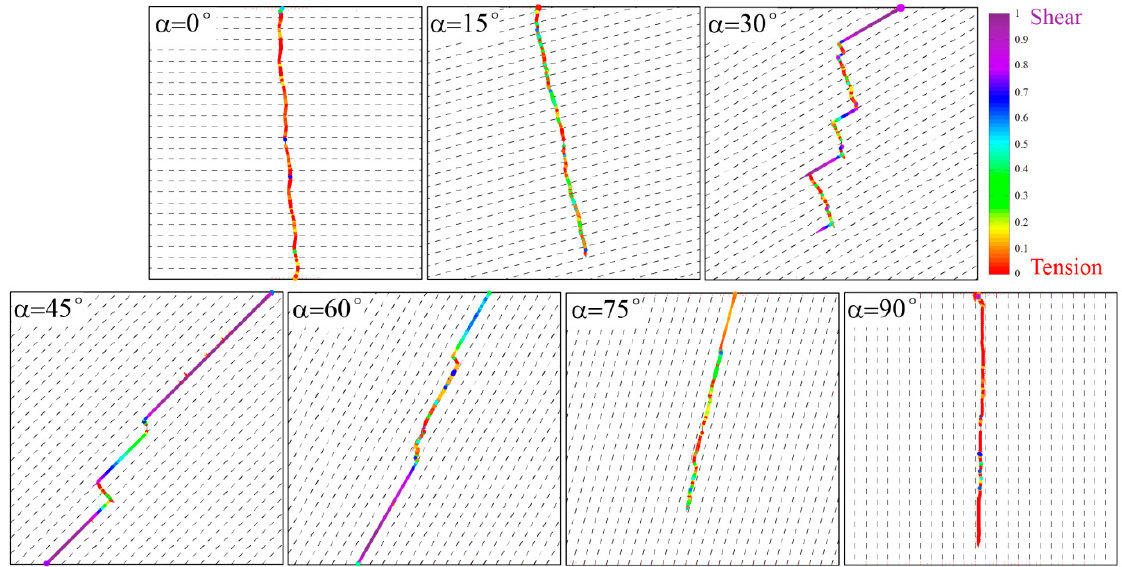
Figure 6. AE-location map. Tensile fractures were the main fracture type during fracturing. Bedding slip fractures (a type of shear fracture) were the most obvious when the BP angle was 45°. The AE energy of crack tip was low.